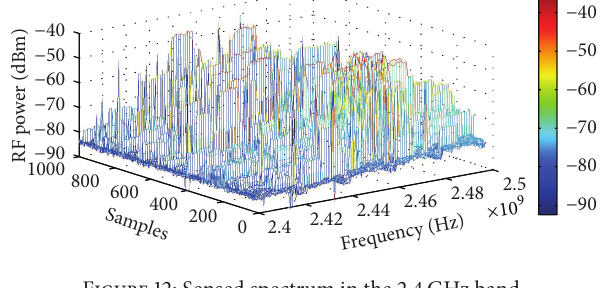
Figure 12: Sensed spectrum in the 2.4 GHz band.